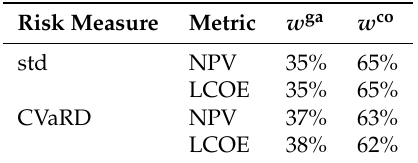
Figure 4. Power portfolio opportunity sets under the stochastic LCOE metric. The 40-year plant lifetime scenario: ( a ) the standard deviation case; ( b ) the CVaRD case. In the y -axis, LCOE stands for expected LCOE. Continuous red lines depict two-asset, gas and coal, portfolio opportunity sets. Table 7. The composition of minimum risk portfolios in the 40-year portfolio selection problem. The two-asset